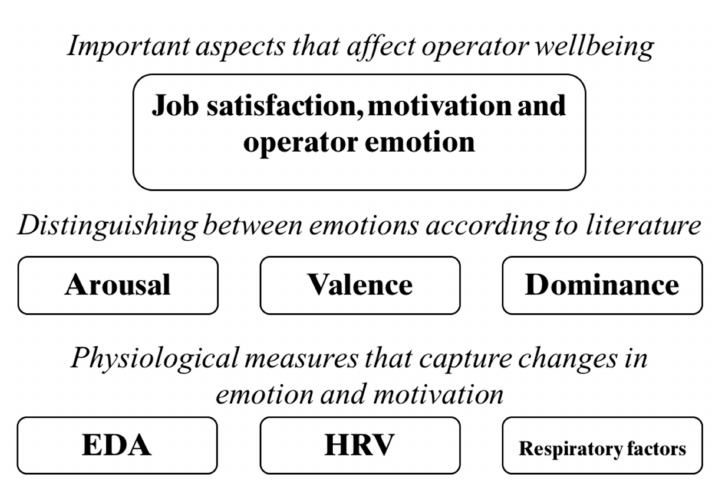
Figure 1. Model for assessing changes in motivation and operator emotion adapted from the introduction, and ways to assess affect from Russell [43], Stamps [44], Mehrabian and Russel [45].